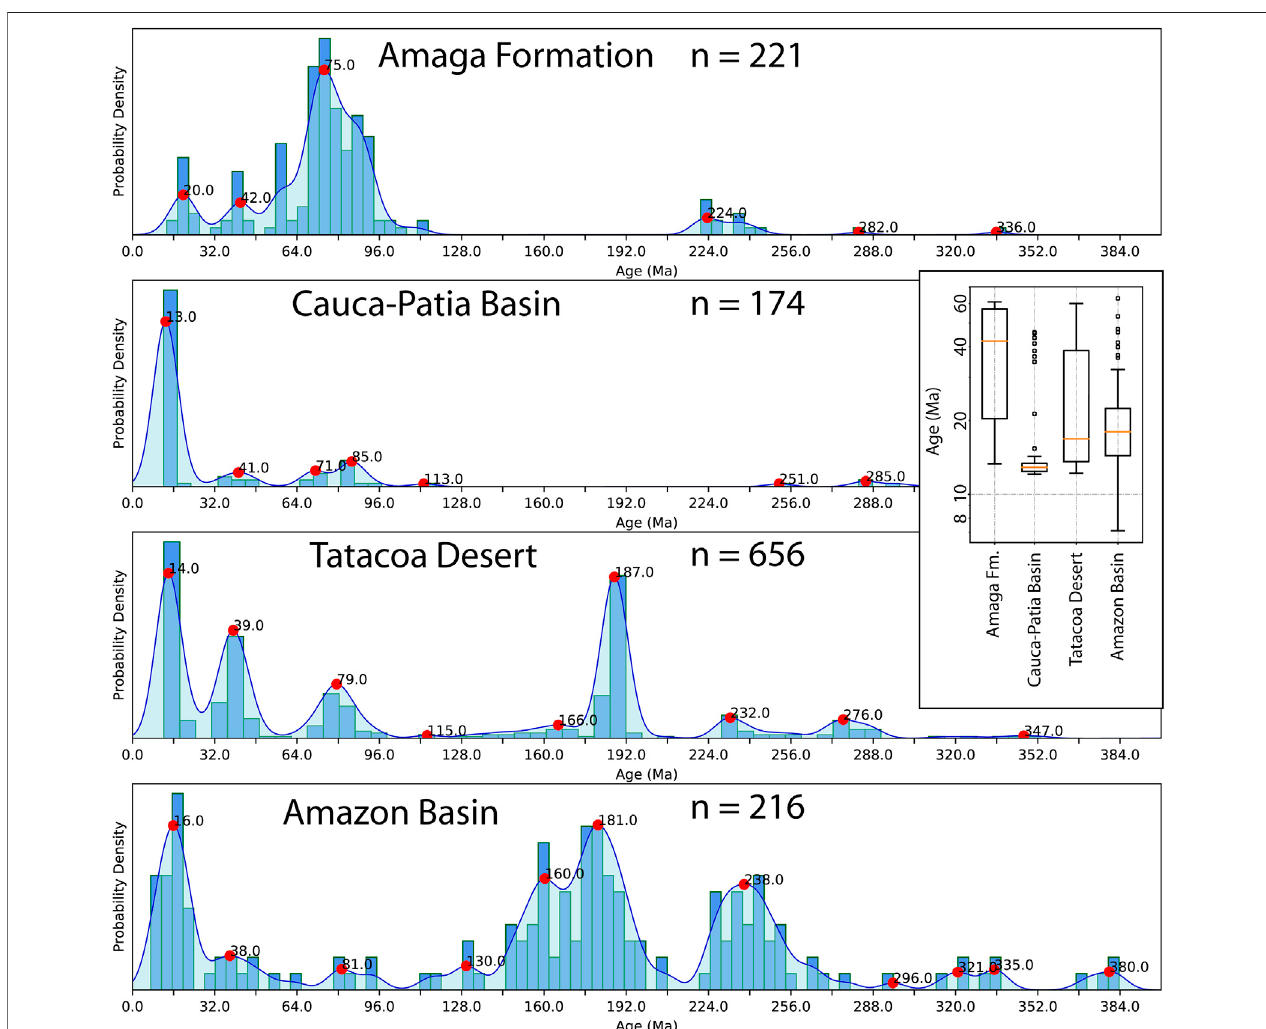
FIGURE 11 | Histograms and probability density plots of detrital zircon populations in four different middle Miocene localities in the Northern Andes showing only the last 400 Ma. From top to bottom: Amaga Formation, Cauca-Patia Basin, Tatacoa Desert, and Amazon Basin (Echeverri et al., 2015; Montes et al., 2015; Anderson et al., 2016; Kern et al., 2020), see Figure 1 for locations. All contain a distinctive middle Eocene and middle Miocene populations, with a Jurassic peak only present downstream from the Tatacoa Desert. Inset shows box and whisker plots comparing Cenozoic detrital zircon populations in the same localities.